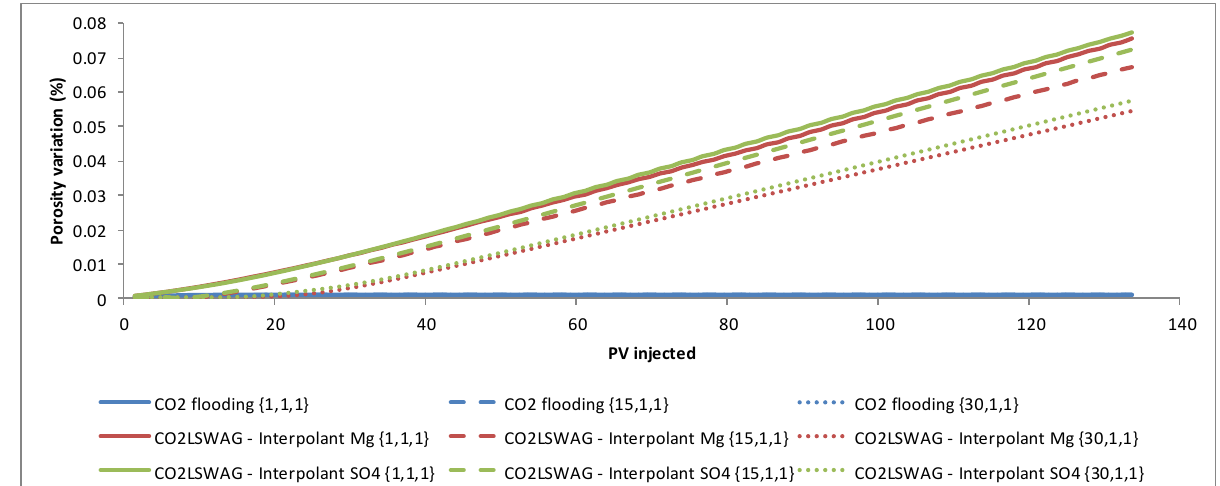
Figure 5. Water cut for CO 2 -LSWAG considering Mg and SO 4 as interpolant ions and gas – oil ratio for continuous CO 2 injection.